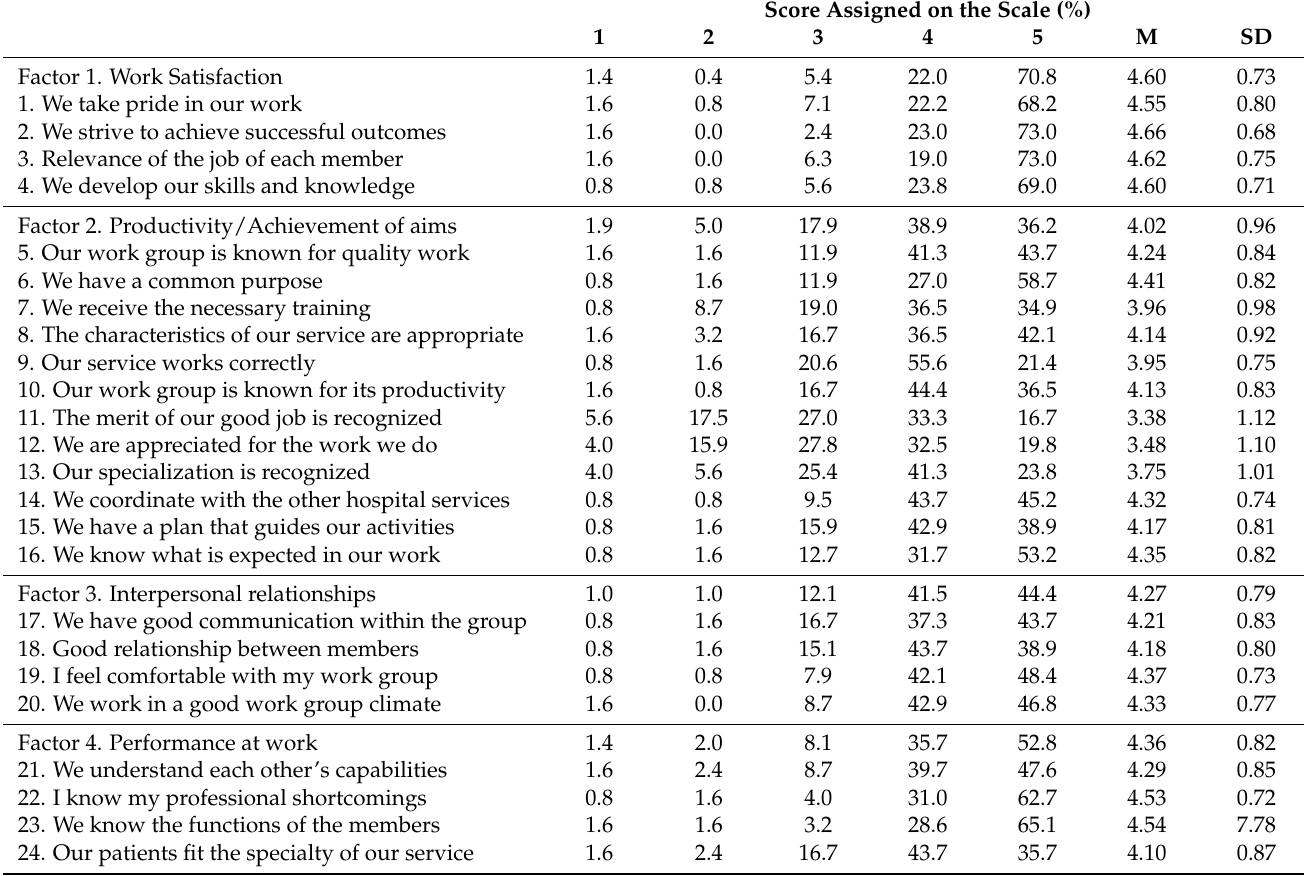
Table 6. Response values for each item and factor (abridged